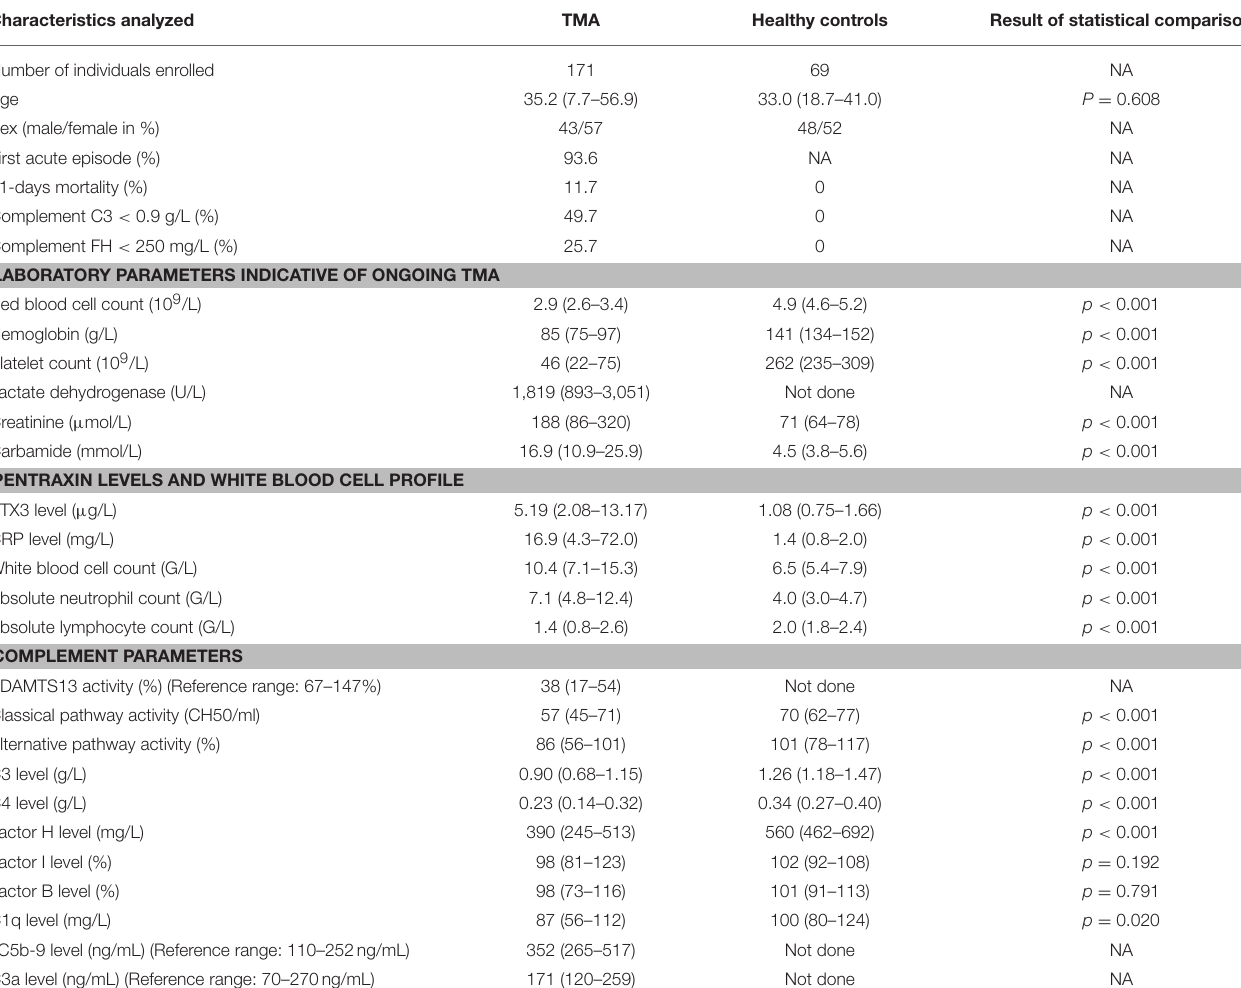
TABLE 1 | Characteristics of the TMA patients and healthy controls. Characteristics